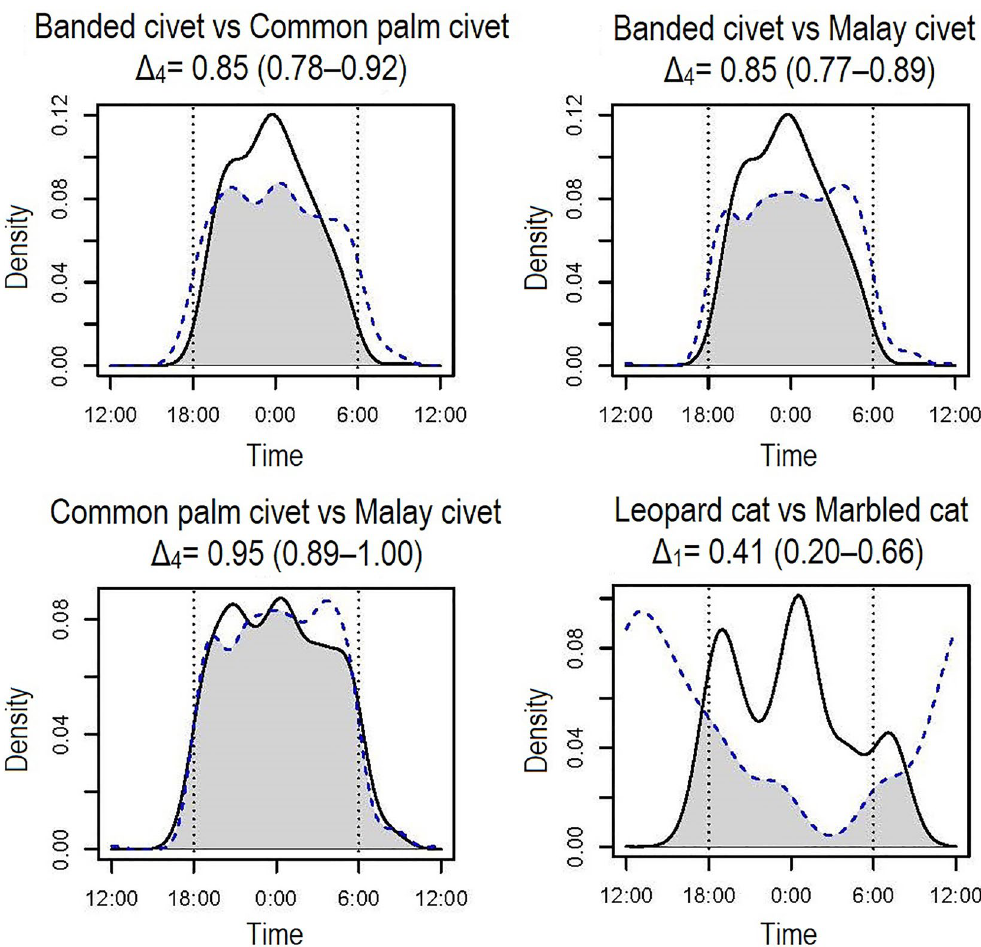
Figure 3. Temporal activity overlaps among the carnivore species belonging to the same family. Solid lines indicate species before "vs", and dotted lines indicate those after "vs". Grey shared areas indicate the coefficient of overlaps (Δ1 and Δ4) of the two density estimates. Dotted vertical lines indicate approximate times of sunset and sunrise, and short vertical lines under the kernel density curves indicate photo-captured times of each